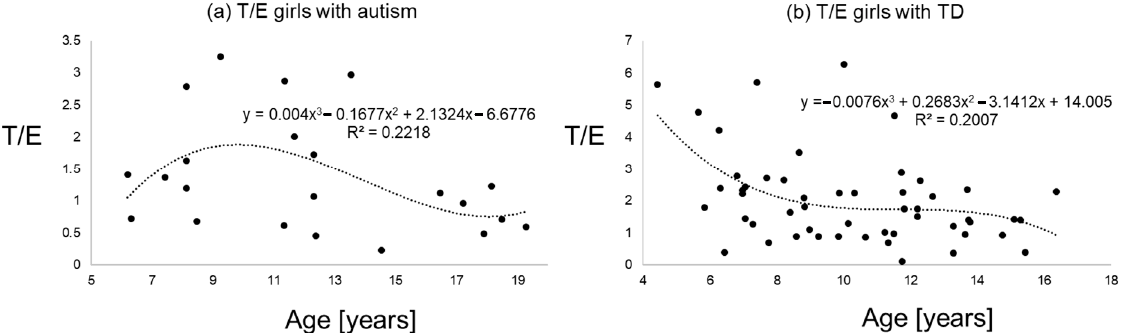
Figure 3. T/E ratios of girls with autism ( a ) versus typical development ( b ) the line shows a polynomial interpolation of third degree.